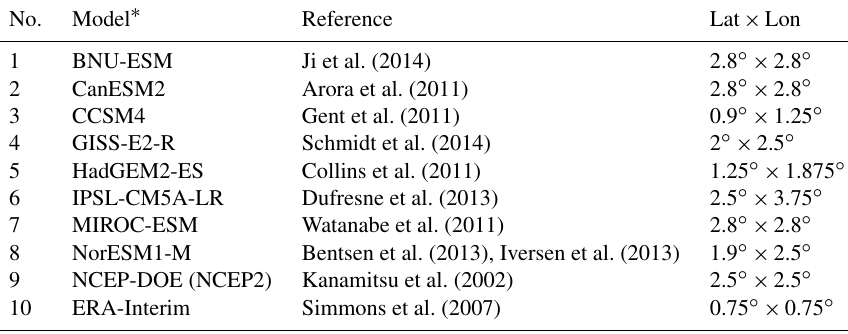
Table 1. The GeoMIP and CMIP5 models and the reanalysis data used in the paper.